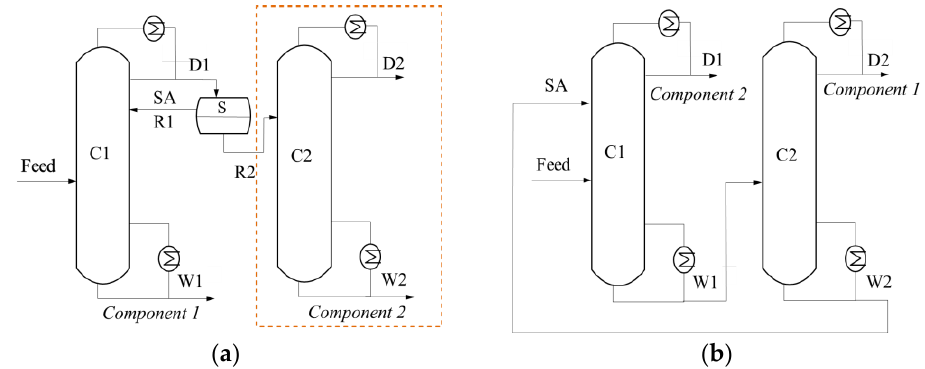
Figure 2. Separation flowsheets: ( a ) heteroazeotropic distillation; ( b ) extractive distillation. Ci — distillation column, S — separator, Di (Wi) — distillate (bottom) flow, Ri — flows leaving the separator, 1(2) — refers to the column number. Table 4. The columns operation